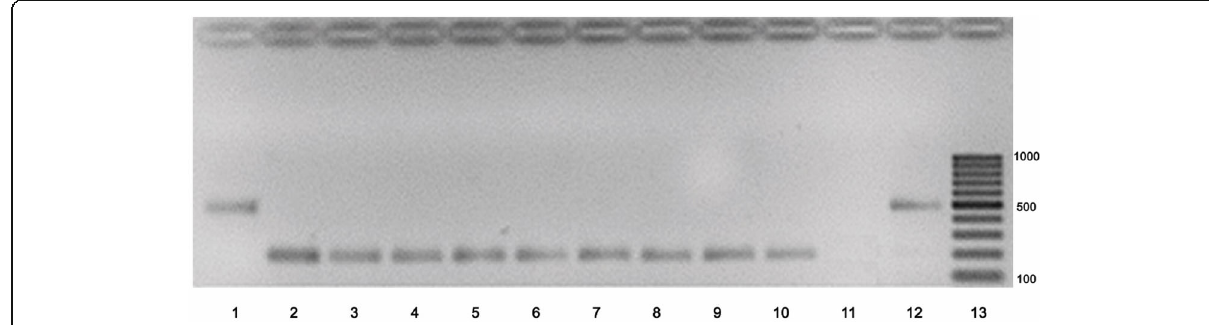
Fig. 1 Visualization of the species-specific multiplex PCR products identifying two species of Trichogramma that parasitize the eggs of the European corn borer, in Serbia. Lane legend, from right to left by ordered numbers: 1 T. evanescens ; lanes 2 – 10 T. brassicae ; lane 11 no template